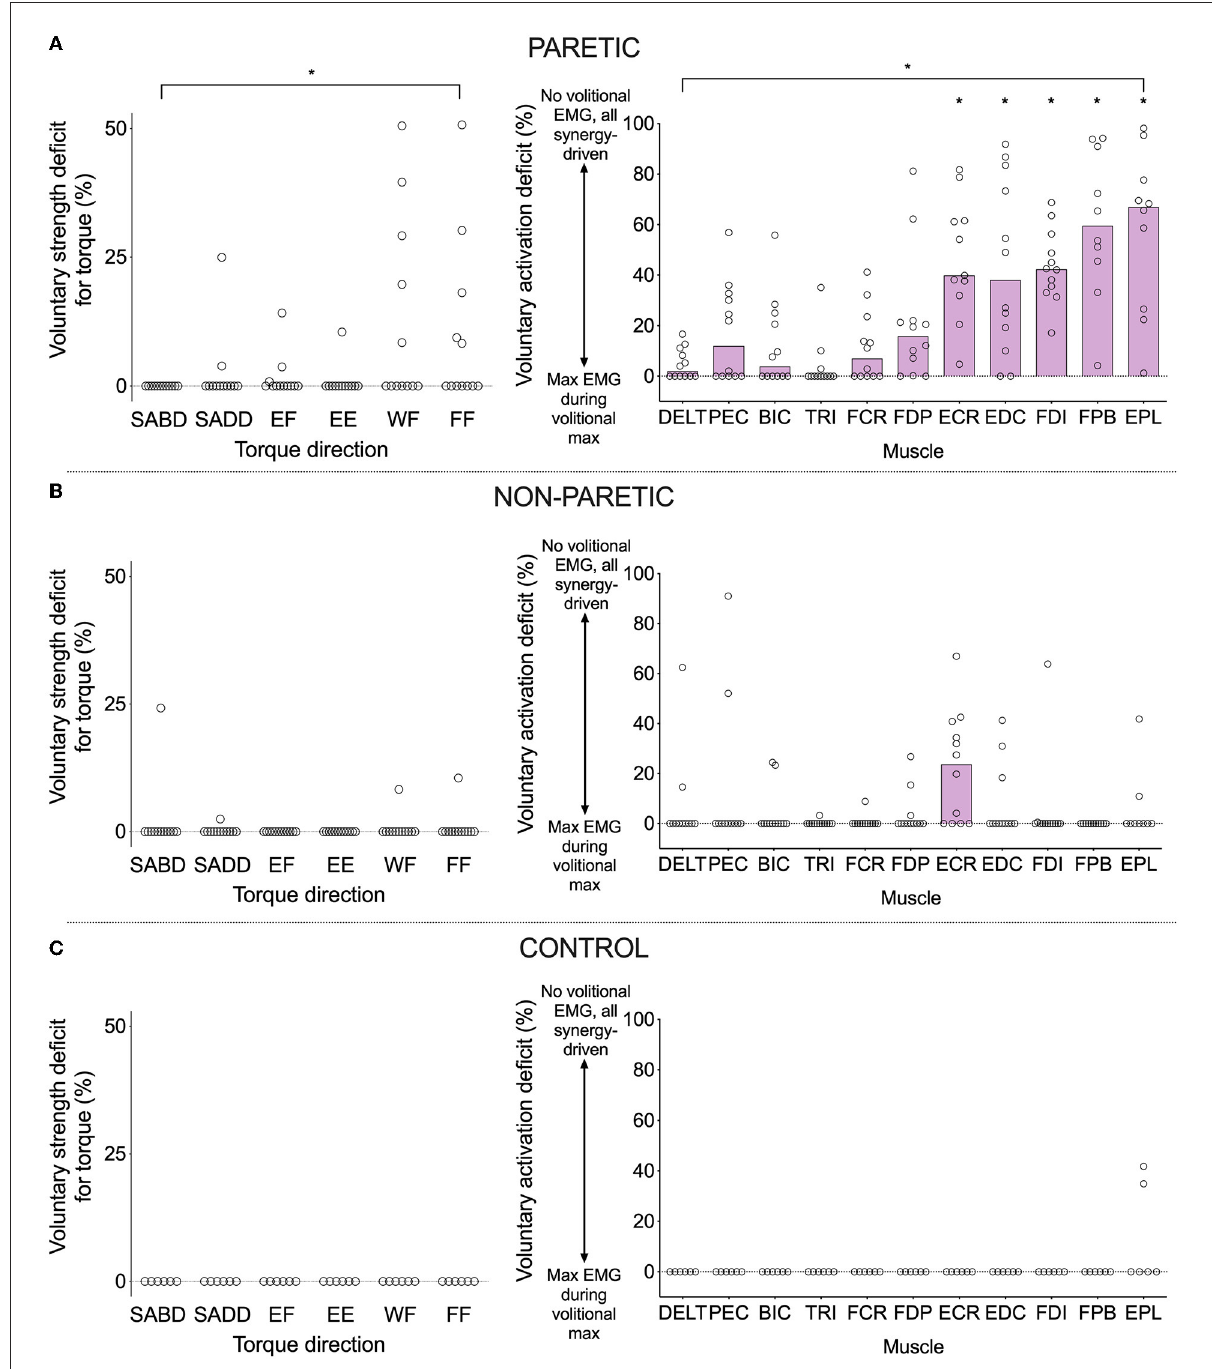
FIGURE2 Voluntary strength deficit in torque (left) and voluntary activation deficit in EMG (right) for the paretic (A) , non-paretic (B) , and control (C) limbs. A value of zero indicates that maximal torque/EMG was obtained during a contraction in the intended/agonist direction, and non-zero values indicate that maximal torque/EMG was obtained during a contraction in a different direction (i.e., synergy-driven). The higher the value, the larger the discrepancy between the voluntary and synergy-driven values. Circles indicate values for individual participants, and purple bars indicate the group median (lack of a purple bar indicates a group median of zero). Asterisks indicate significant differences between values for a particular muscle and those of the deltoid at p ≤ 0.05 (*). Exact p -values are presented in the